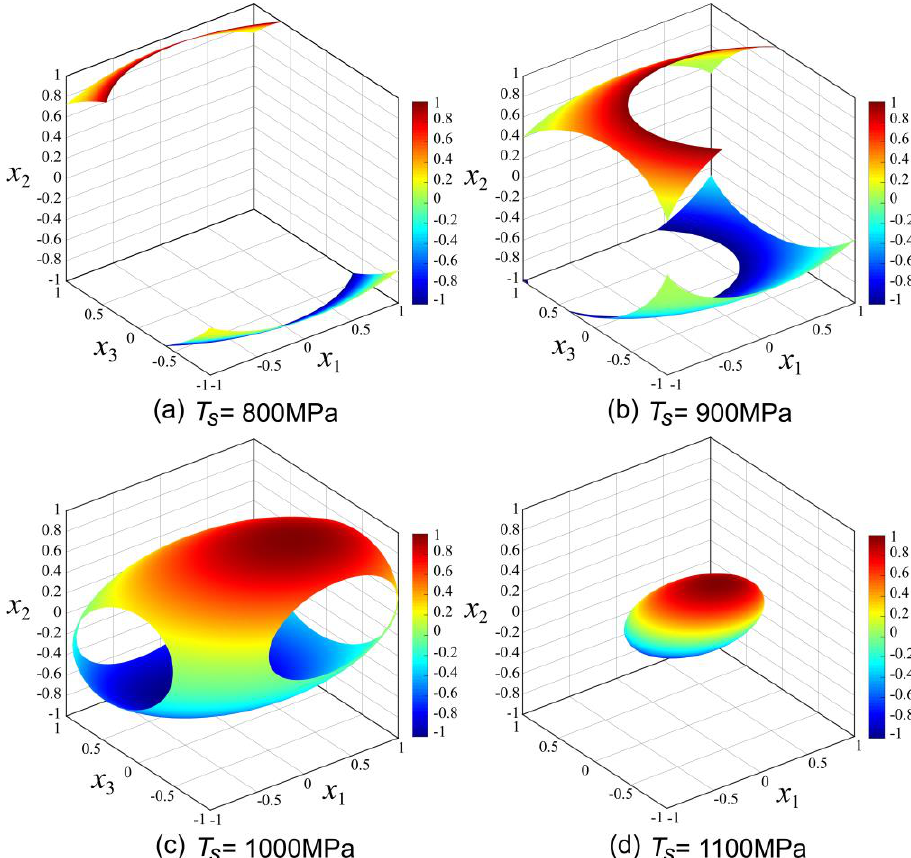
Figure 5. Iso-surfaces for different tensile strength values in three-dimensional factor space. ( a ) Iso-surface diagram of T S = 800 MPa; ( b ) Iso-surface diagram of T S = 900 MPa; ( c ) Iso-surface diagram of T S = 1000 MPa; ( d ) Iso-surface diagram of T S = 1100 MPa.